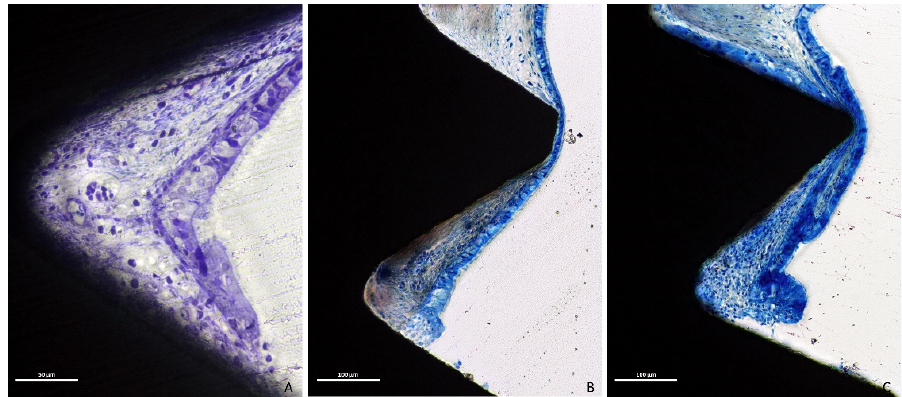
Figure 8. Photomicrographs of ground sections. ( A ), thinned mucosa around the last threads and the apex (at the bottom). ( B , C ), the sinus mucosa surrounding the exposed threads generally presented lower amount of inflammatory infiltrated compared to the apical exposure. ( A – C ), Toluidine blue stain.